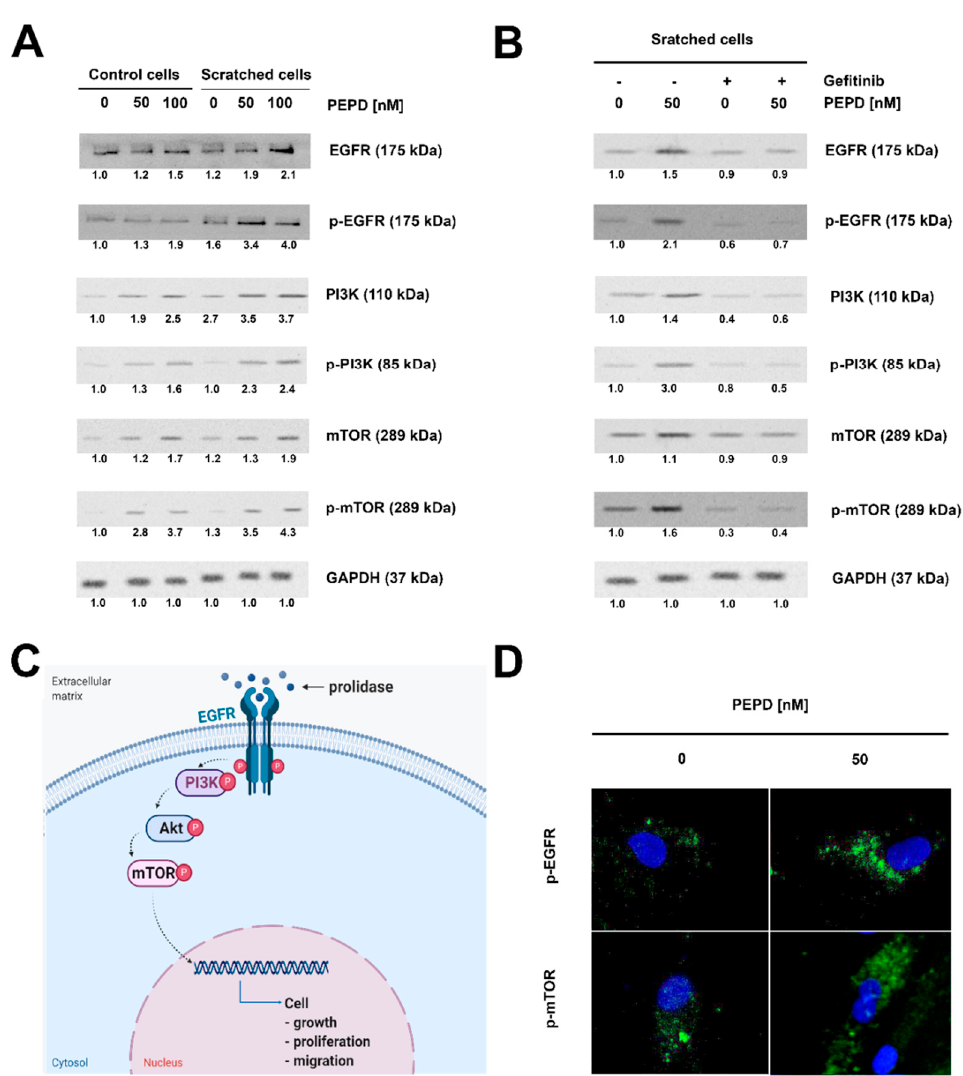
Figure 3. Extracellular PEPD-induced epidermal growth factor receptor (EGFR)-downstream signaling pathway. ( A ) Western blot for the proteins of EGFR-downstream signaling pathway in lysates of control and “scratched” PEPD-treated fibroblasts (PEPD, 1 − 100 nM) for 24 h or PEPD-treated fibroblasts (PEPD, 0 and 50 nM) with an inhibitor of EGFR (Gefitinib pretreated cells for 2 h, 0 and 45 µM) for 24 h. GAPDH was used as a loading control. ( B ) Representative blot images were shown (densitometry of protein stains is presented under protein bands as a ratio versus control; Supplementary Figure S1). GAPDH was used as a loading control. ( C ) Illustration of the PEPD-dependent EGFR-downstream signaling pathway. Created with BioRender.com. ( D ) Representative results of immunostaining of p-EGFR and p-mTOR in PEPD-stimulated fibroblasts (50 nM) for 24 h are presented; magnification 200×.